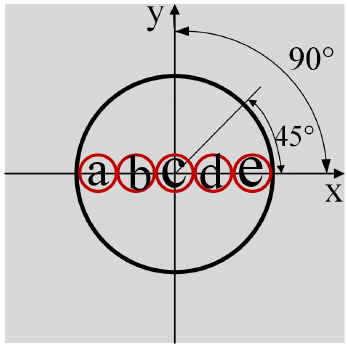
Figure 4. Schematic diagram showing the locations of the test points in the impact area.